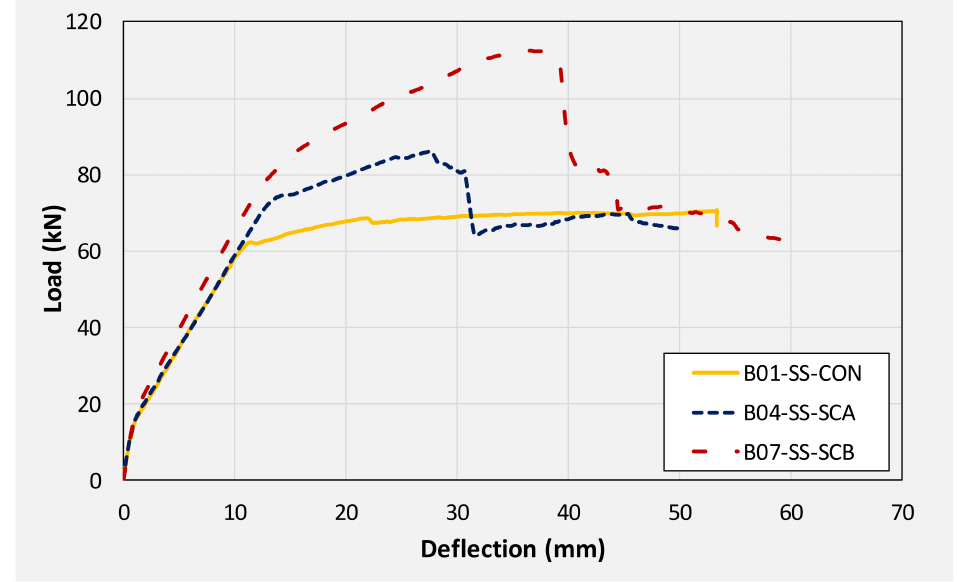
Figure 17. Comparison of load-deflection curves of solid